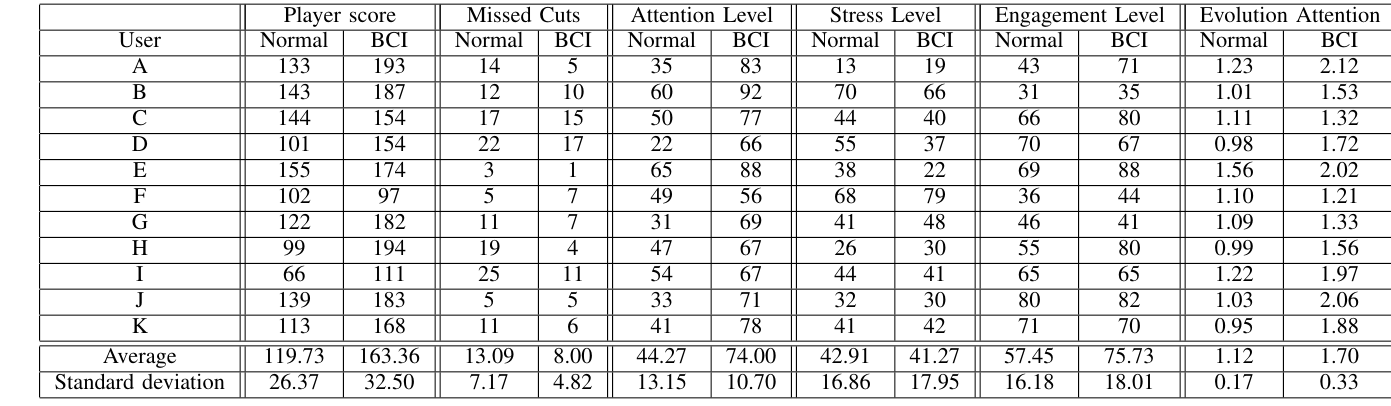
Table III: Results of the usability tests Without the BCI.